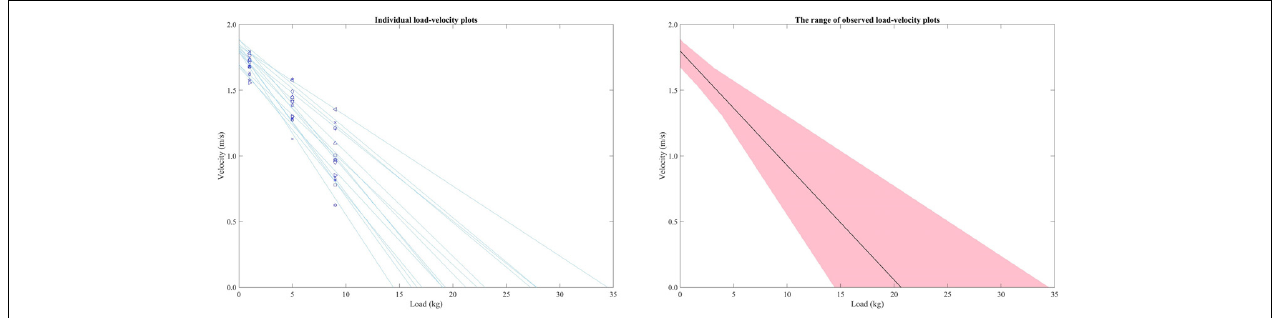
FIGURE 4 | Individual load-velocity profiles obtained in the present study (left panel) and the inter-individual mean and the range of the load-velocity relationship (right panel) .